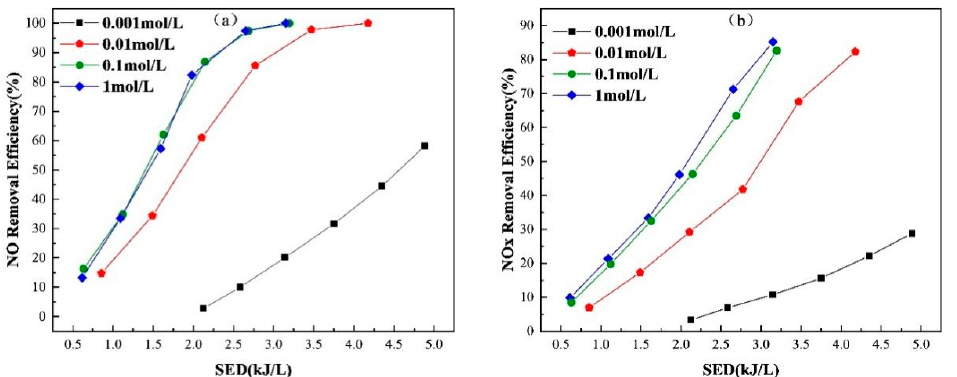
Figure 7. The influence of solution concentration of the ground electrode on NO/NOx removal effi- ciency at different SEDs: ( a ) NO removal efficiency; ( b ) NOx removal efficiency. efficiency at different SEDs: ( a ) NO removal efficiency; ( b ) NOx removal